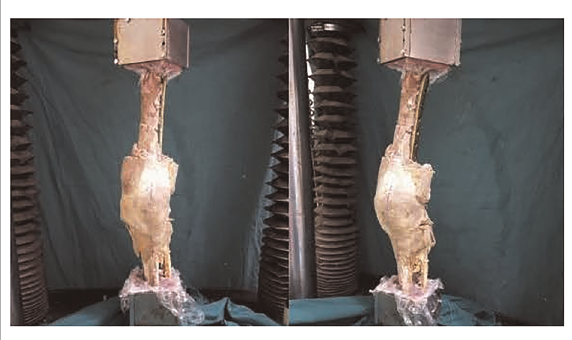
FIGURE 3 Model of external rotatory deformity. The specimens were assembled to the BOSE Electroforce 3520-AT biomechanical testing machine.